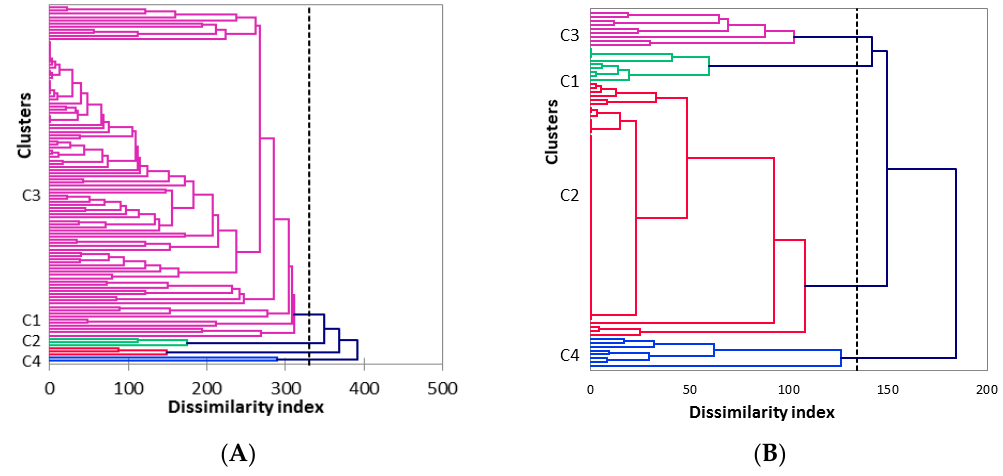
Figure 1. Dendrogram of the agglomerative hierarchical clustering (AHC) of the interdelta PCR for the 112 and 90 yeast isolates from 2016 ( A ) and 2017 ( B ), respectively. The dissimilarity is based on Euclidean distances (pbarret.net, 2005), and clusters are shown in four colours (C1: green; C2: red; C3: purple and C4: blue). In 2016, some of the isolates of the first batch were separated from the others (three isolates from the middle (2016-1MF) and five from the end (2016-1EF) of the alcoholic fermentation). For 2017, the isolates from the first and second batches were mixed in four clusters. Heavy blue line represents the relevant clusters considered. The dotted line corresponds to the minimum dissimilarity level considered in the analysis in order to define the relevant cluster.